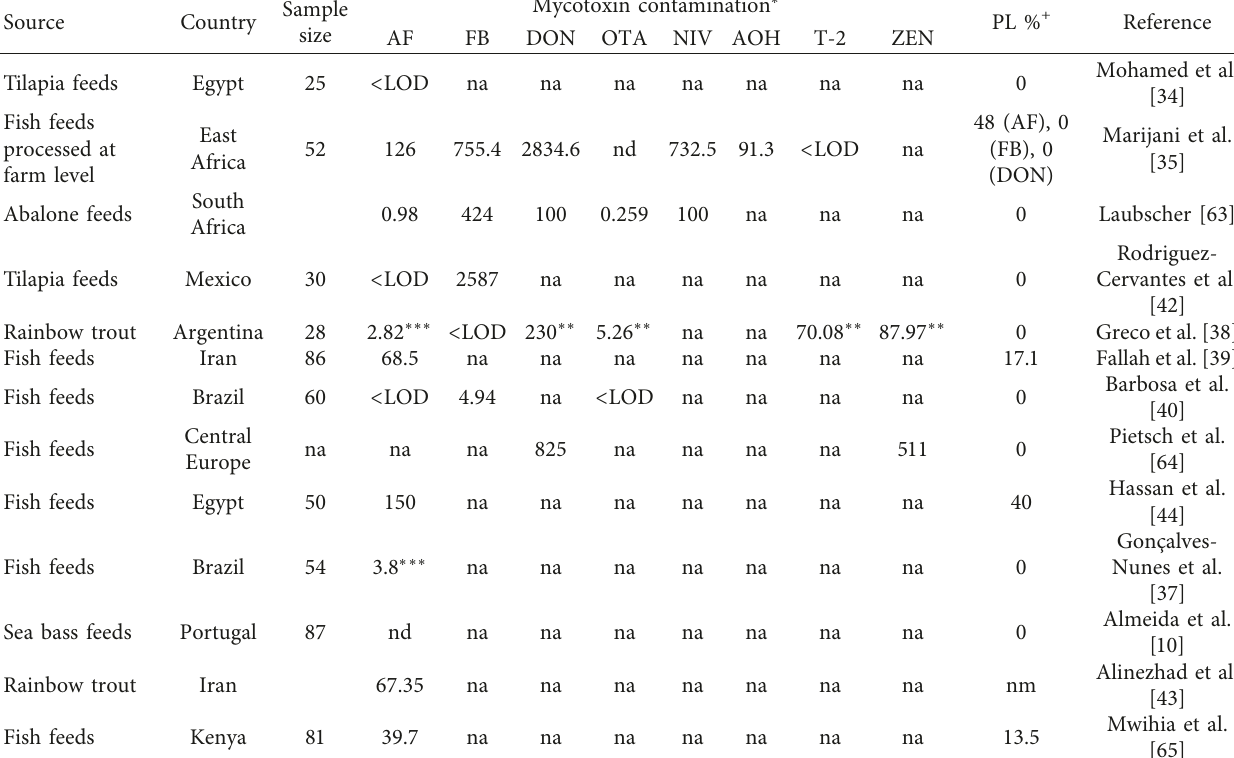
Table 2: Mycotoxin levels ( μ g · kg − 1 ) in fish feed from developing